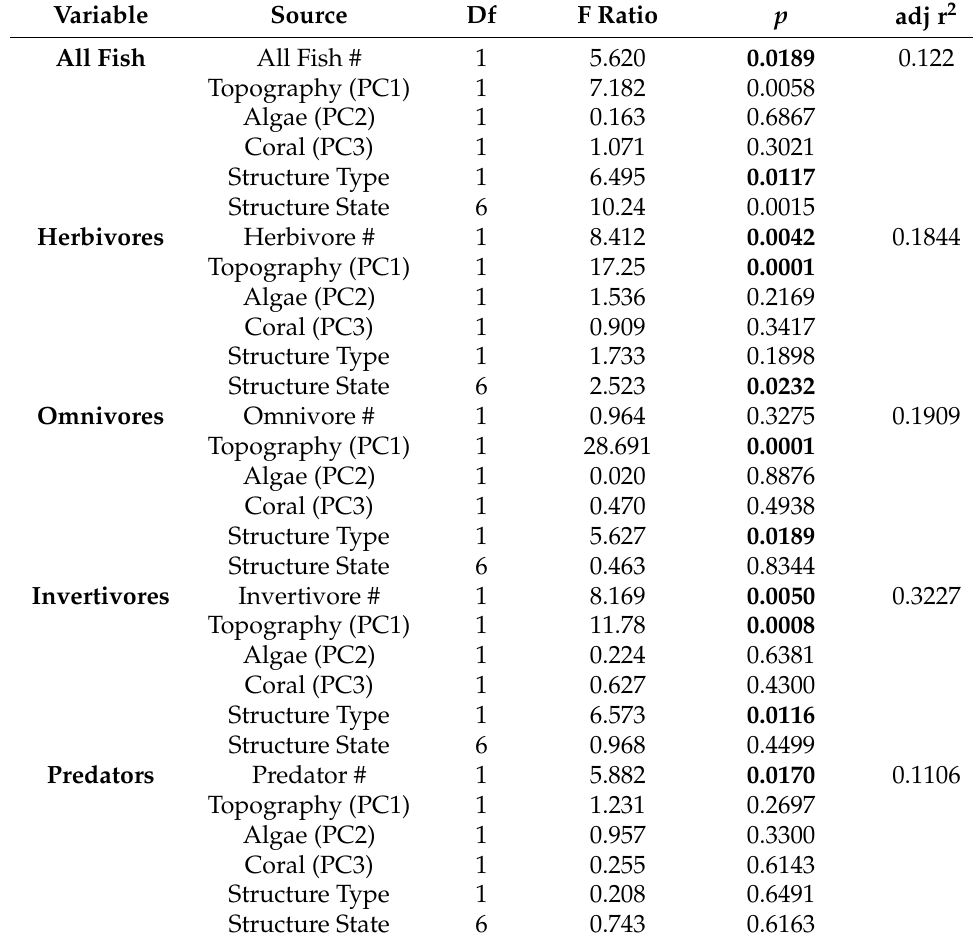
Table 2. Nested analysis of covariance with fish abundance (from video transect surveys), topography, algal cover, and coral cover as covariates and structure type (control, soft, barrel, elkhorn, sea rod, dead coral, diseased coral, and healthy coral) nested within structure state (natural versus artificial). Bolded values indicate significant